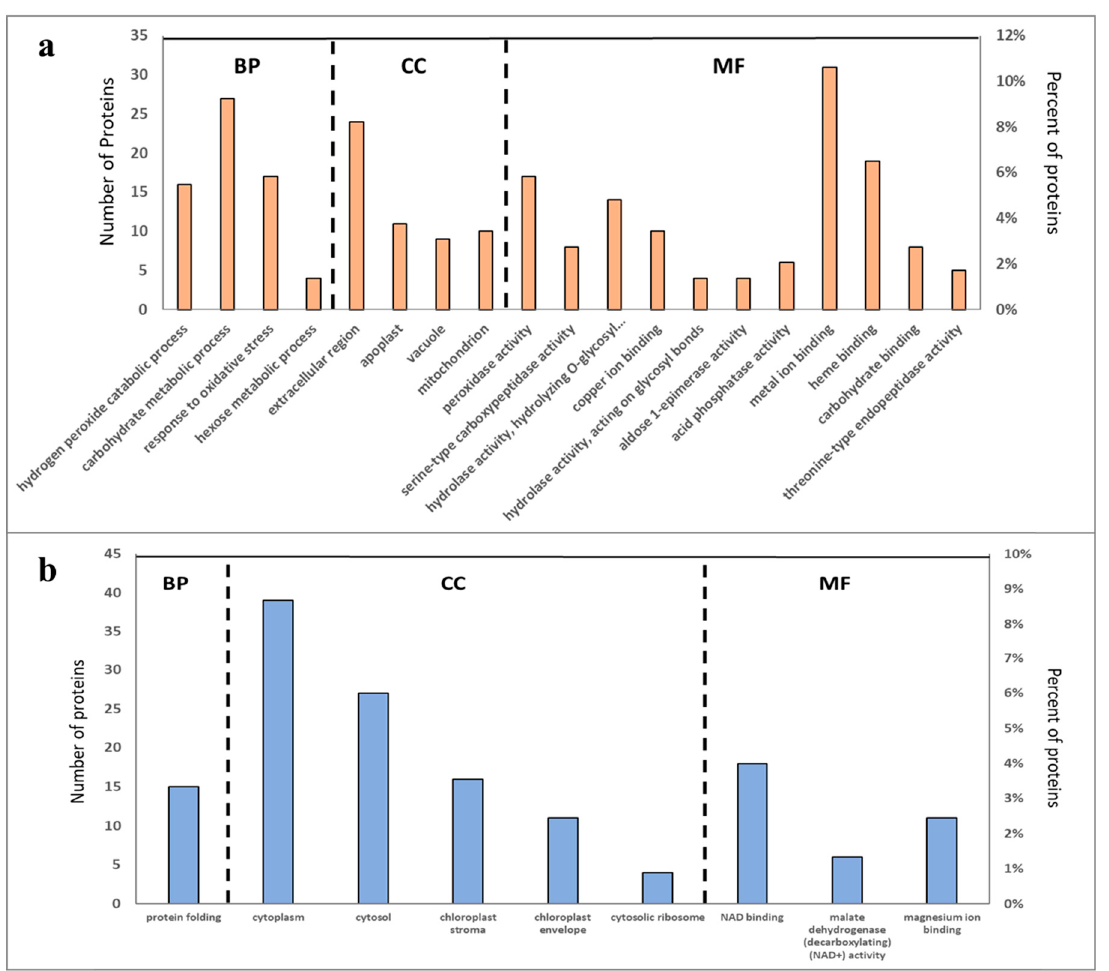
Figure 3. Classification of identified proteins of potato roots as ( a ) more abundant and ( b ) less abun- dant in resistant cultivars from the proteome of potato (Solanum tuberosum) into Gene Ontology (GO) categories, in terms of their involvement in biological process (BP, orange bar), cellular component (CC, green bar), and molecular function (MF, blue bar).